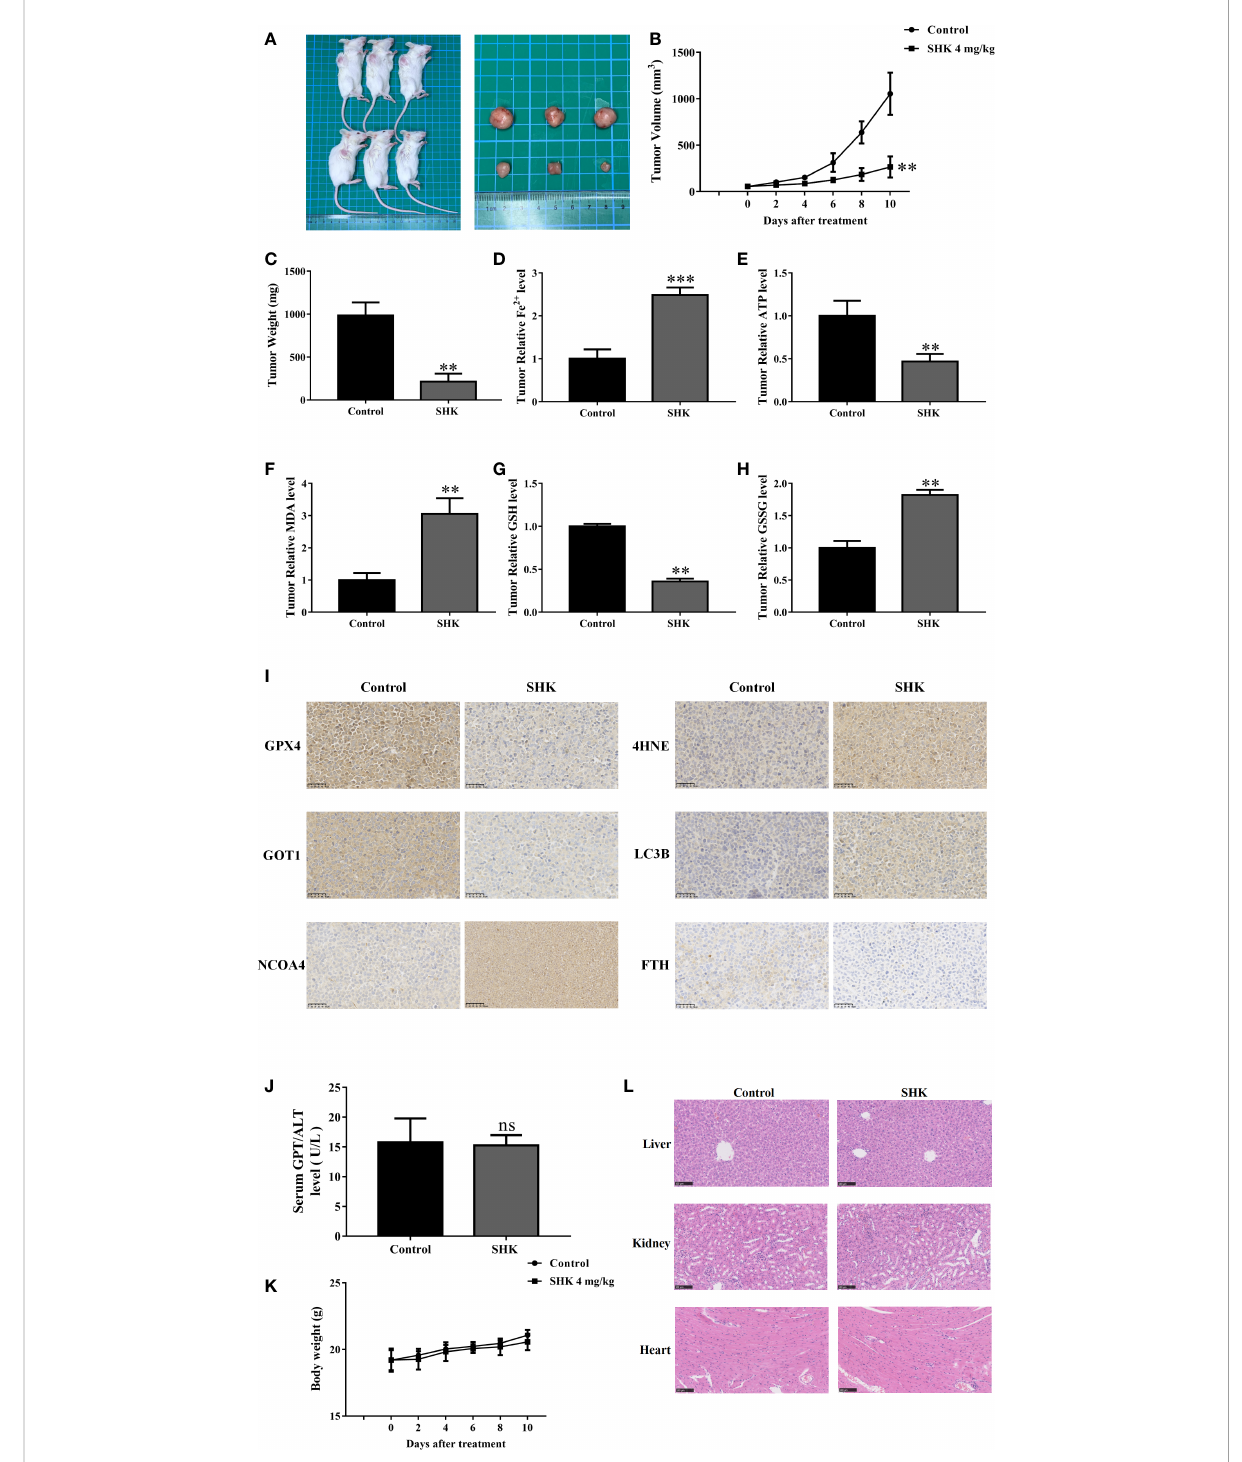
FIGURE 6 SHK results in ferroptosis induction and exerts antitumor ef fi cacy in vivo . (A) Representative image of RPMI 8226 xenograft tumors after SHK treatment. (B) Tumor volume in each group. (C) Tumor weight in each group. (D) Tumor Fe 2+ in each group. (E) Tumor ATP level in each group. (F) Tumor MDA level in each group. (G) Tumor GSH level in each group. (H) Tumor GSSG level in each group. (I) IHC staining were used to assess GPX4, 4HNE, GOT1, NCOA4, FTH1 and LC3B levels in tumor tissues. (J) Serum ALT in each group. (K) Body weight in each group. (L) HE stain in liver, kidney and heart of each group. Data are presented as the mean ± SD. ns, not signi fi cant; ** p < 0.01, *** p <